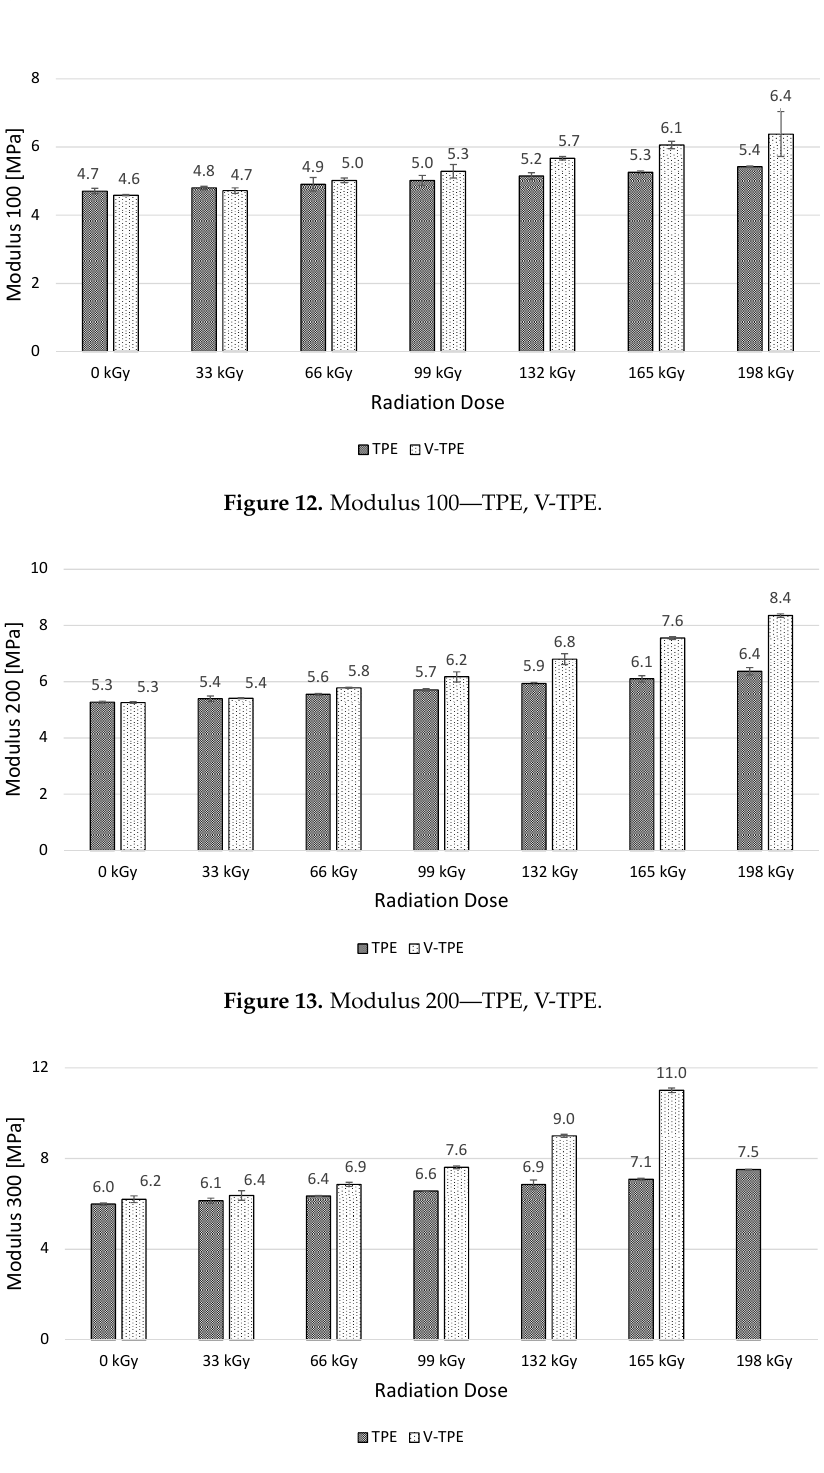
Figure 14. Modulus 300—TPE,